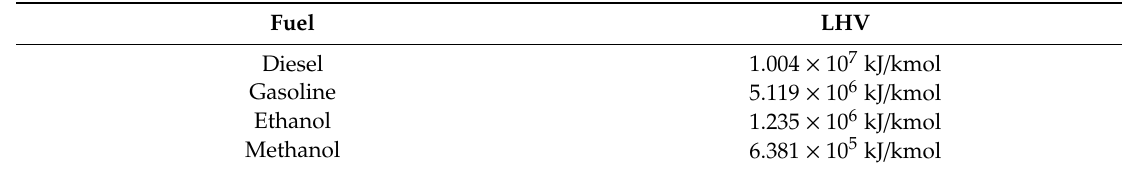
Figure 4. Required heat duty for steam reforming and additional fuel amount per produced H 2 (1 kmol) for diesel, gasoline, ethanol, and methanol. Table 3. Fuel LHV (lower heating value, Std. condition).